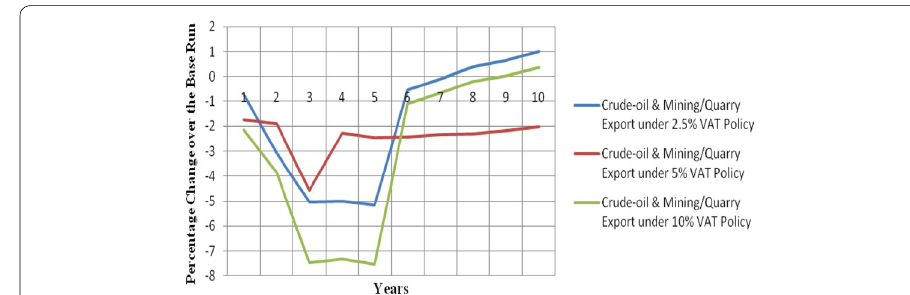
Fig. 45 Changes in crude oil/gas and mining/quarry exports under varying VAT rates